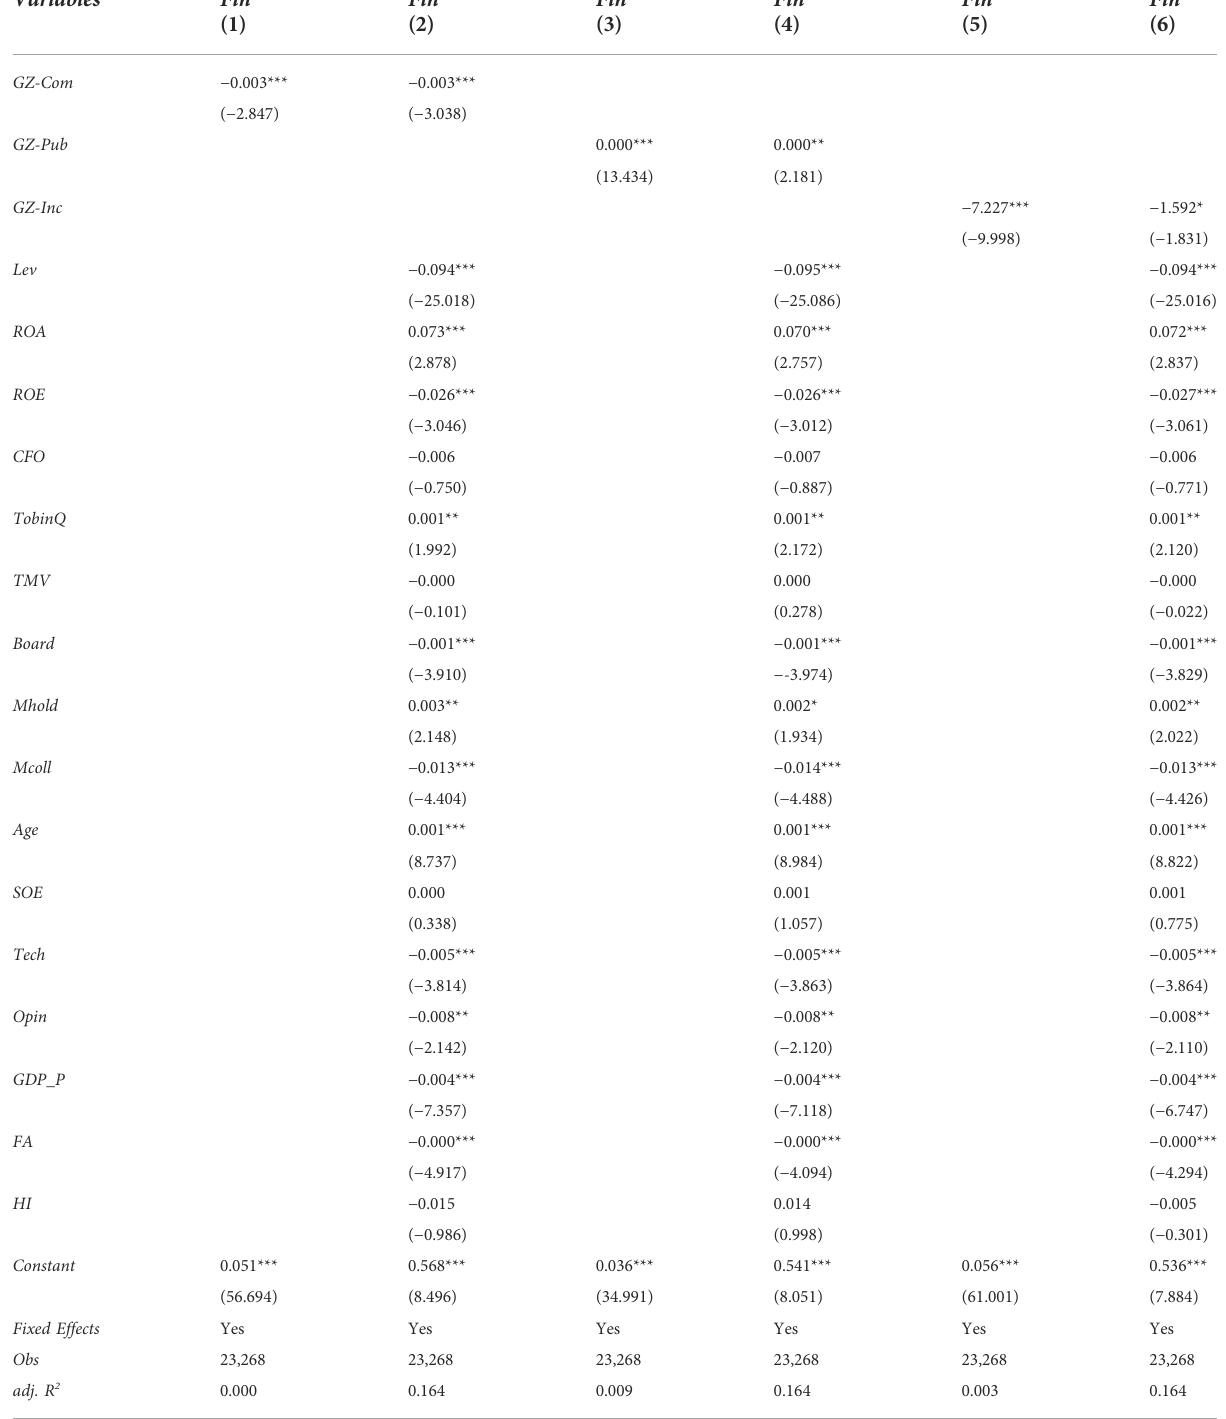
TABLE 3 Impact of environmental regulation tools on fi nancial investment